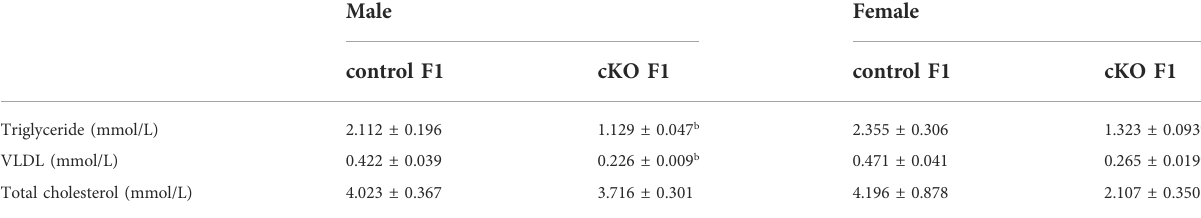
Results are expressed as mean ± SEM. a p <